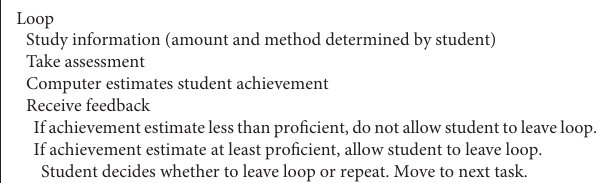
is designed to cover many different academic subjects. If these specifics are not stated in the rules then they can be